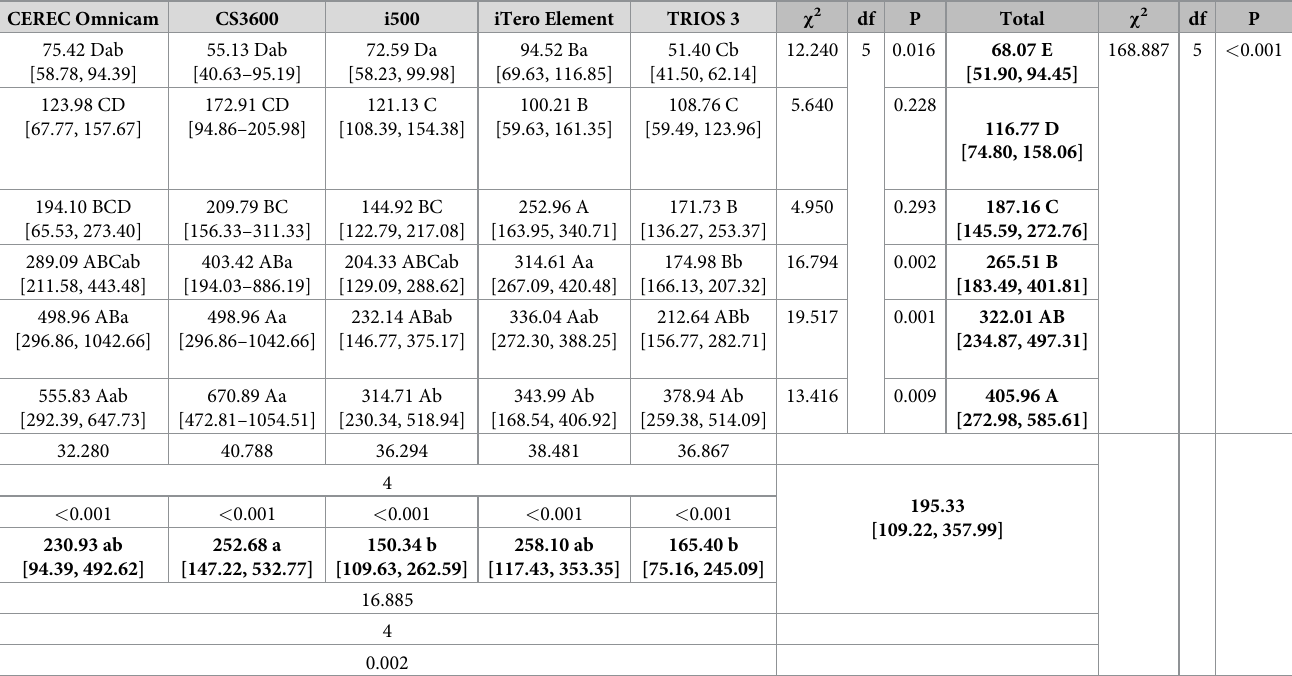
Table 4. 3D root mean square deviation ( μ m) at each cylinder